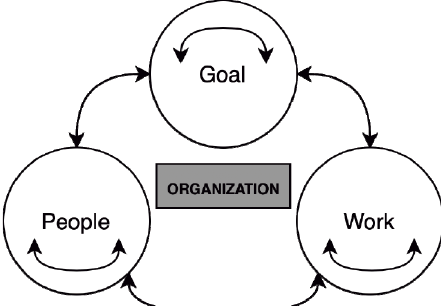
Figure 1. General Model of Organization (Wang & Zeng,